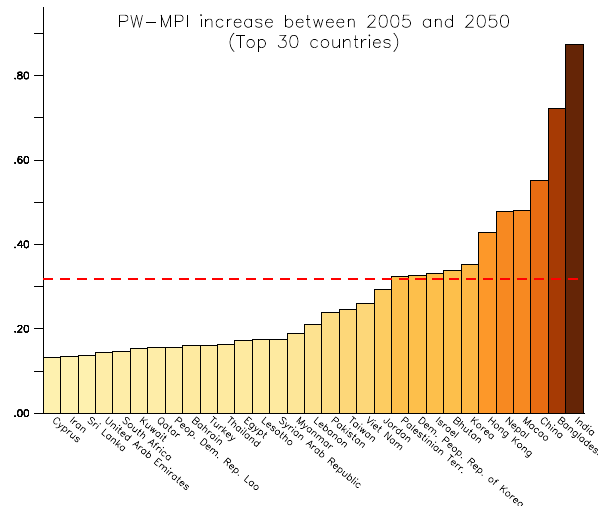
Fig. 14. PW-MPI changes between 2005 and 2050 for different countries (30 countries with the strongest changes). The red dashed line depicts the global PW-MPI increase between 2005 and